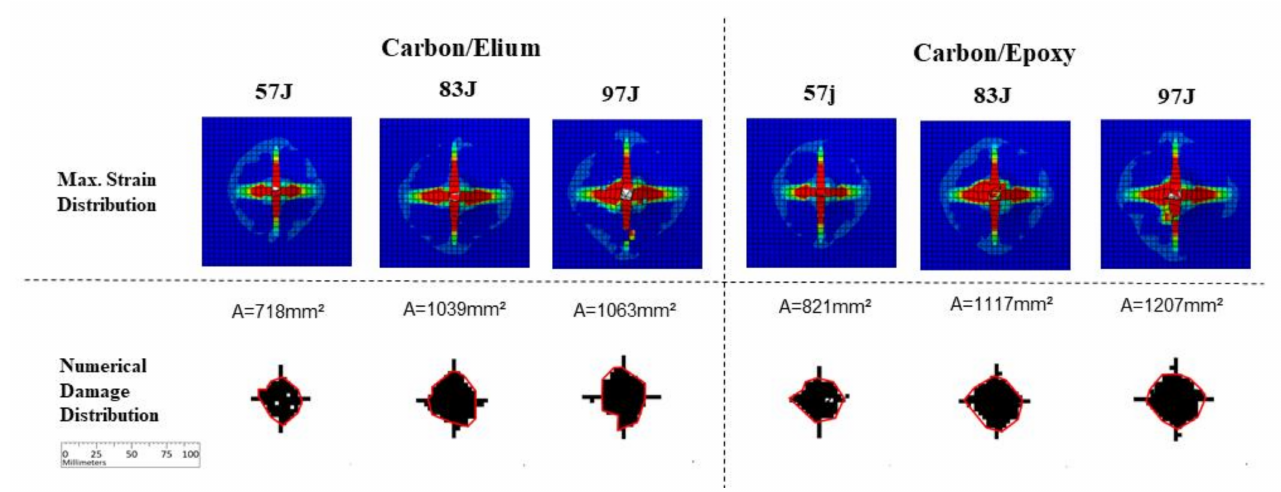
Figure 17. Numerical results for carbon fiber